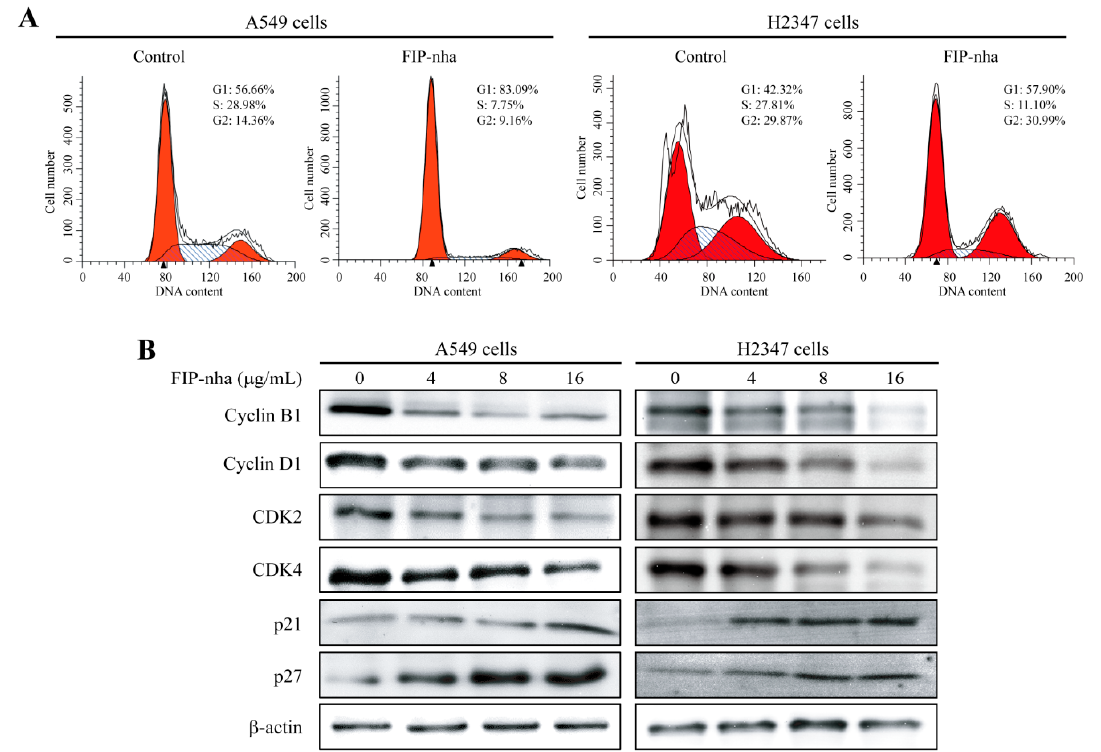
Figure 4. FIP ‐ nha induces G1/S and G2/M cell cycle arrest in lung adenocarcinoma cells. ( A ) A549 and H2347 cells were treated with 8 μ g/mL FIP ‐ nha for 24 h and cell cycle distribution was determined by flow cytometry. Untreated cells were used as control. ( B ) Western blotting analysis of cyclin B1, cyclin D1, CDK2, CDK4, p21, and p27 protein expression in A549 and H2347 cells after exposure to FIP ‐ nha at 0, 4, 8 and 16 μ g/mL for 24 h.